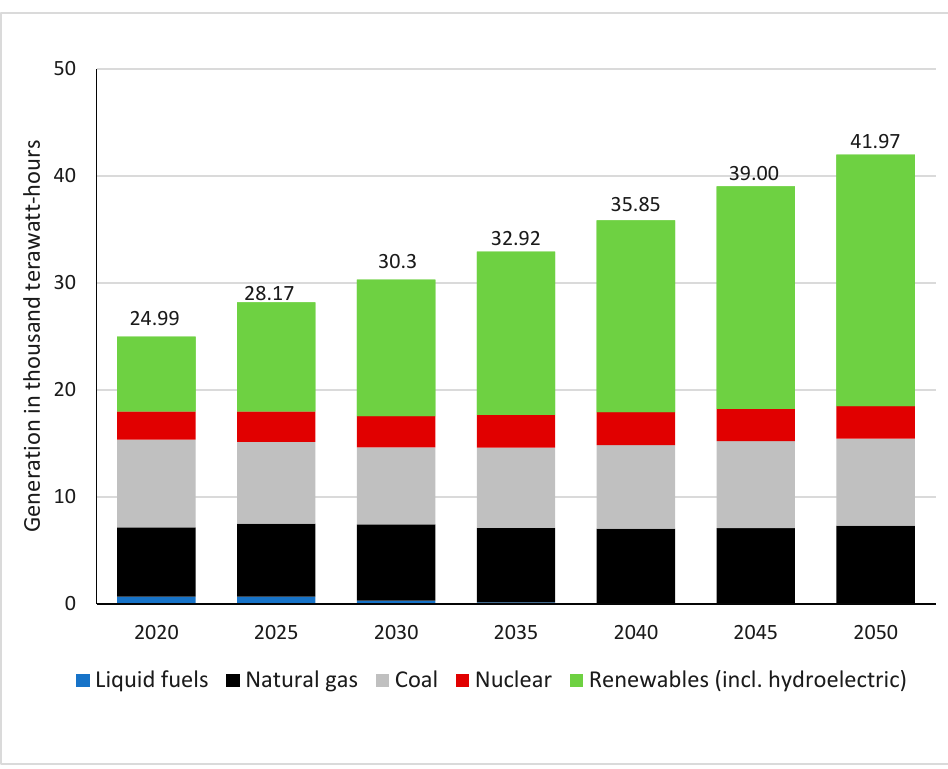
Figure 1. The forecast of worldwide electricity consumption, for the period of 2020 to 2050 [1].